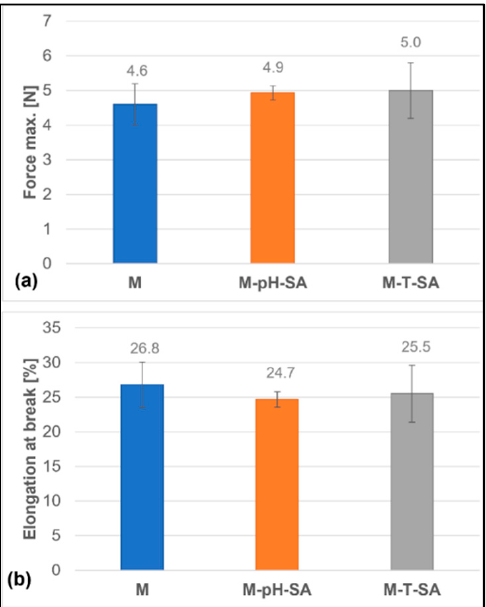
Figure 10. Elongation at break ( b ) and maximum force ( a ) in a static stretching test of bio-hybrid hydrogels ( n = 5).